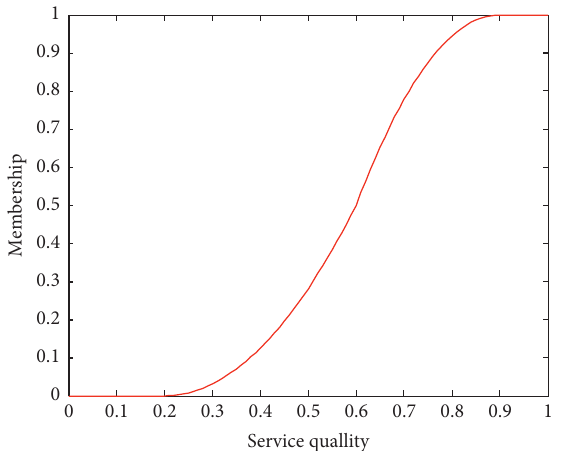
Figure 8: A’ s membership function.